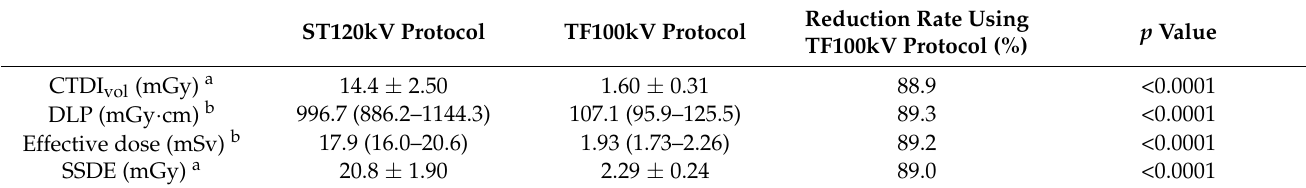
Table 3. Radiation metrics of each protocol.